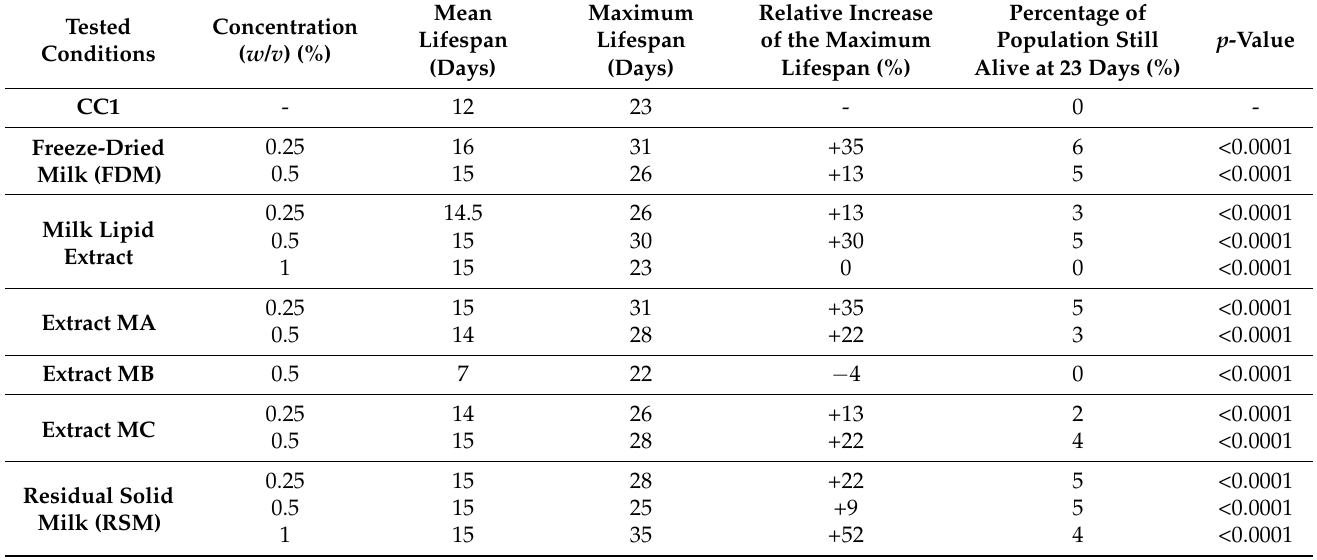
Table 7. Data of the longevity assay of the wild-type C. elegans N2 strain on the medium supplemented with the FDM (freeze-dried milk), milk lipid extract, extracts MA (obtained with dichloromethane), MB (obtained with ethyl acetate), MC (obtained with absolute ethanol) and the RSM (residual solid milk), and CC1 as a control. Mean lifespan, maximum lifespan and the percentage of the population still alive are from the survival curves. p -values were calculated by comparing conditions with the CC1 using the log-rank